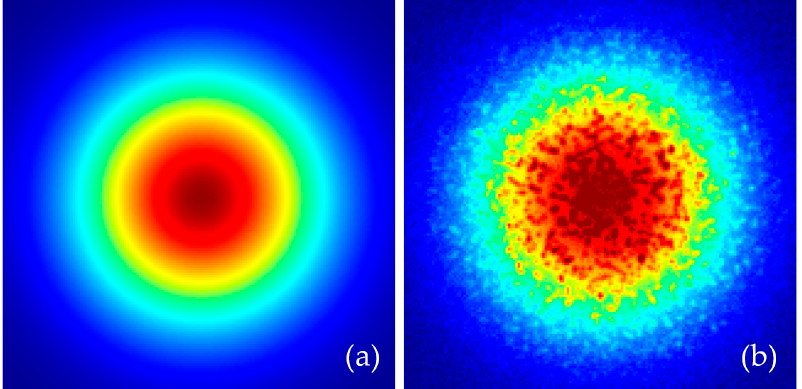
Figure 4. Simulation diagram of light-field distribution in front of a cylindrical lens. ( a ) Gaussian beam without noise; ( b ) consideration of speckle and environmental noise.